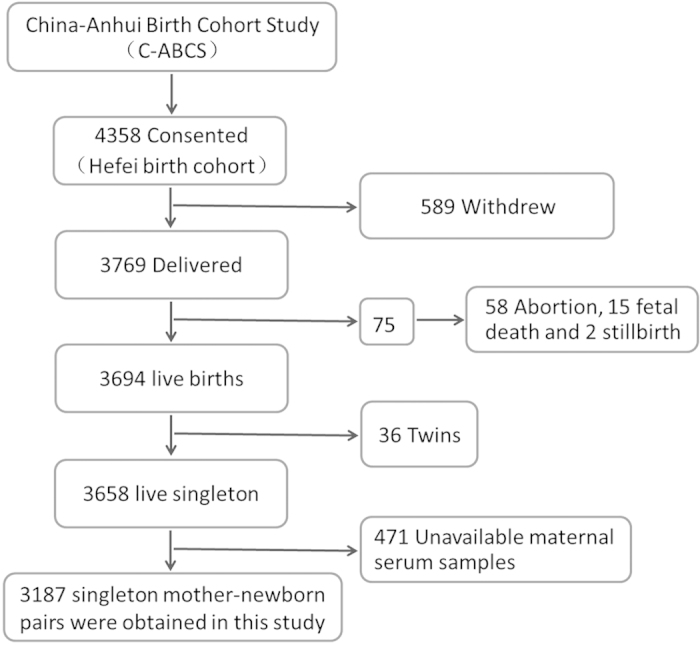
Flow diagram of recruitment and follow-up in this birth cohort study.